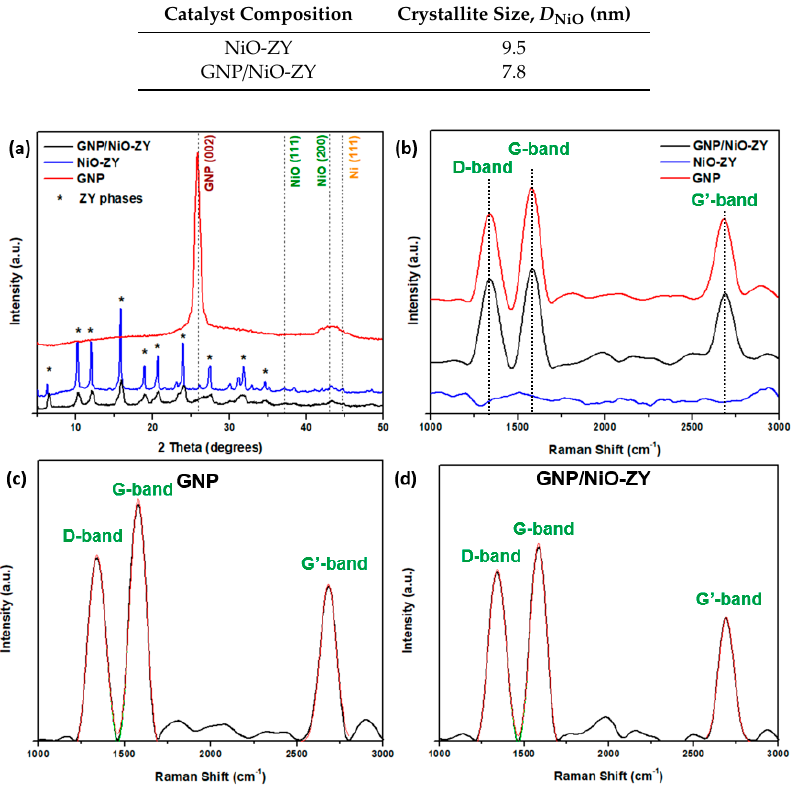
Table 2. Crystallite size calculated from XRD pattern using the Scherrer equation. Catalyst Composition